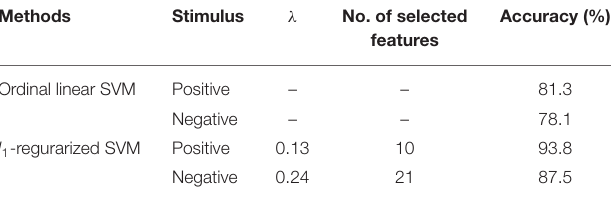
TABLE 2 | The highest classification accuracy using the ordinary linear support vector machine (SVM) and the l 1 -regularized SVM, respectively. Methods